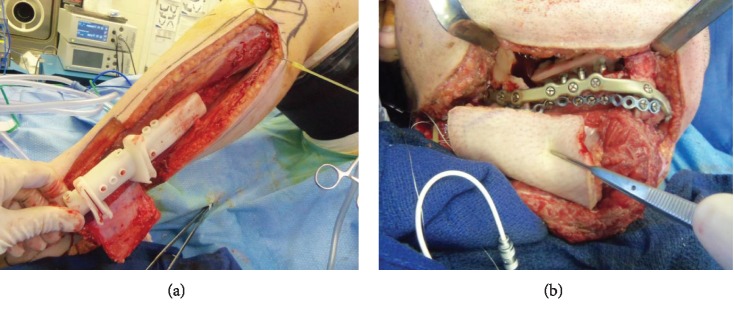
Intraoperative photos. (a) Showing fibula free flap harvest. No abnormal bleeding encountered during harvest or after release of tourniquet. (b) Fibular bone inset at the mandible via transcervical approach with good hemostasis.